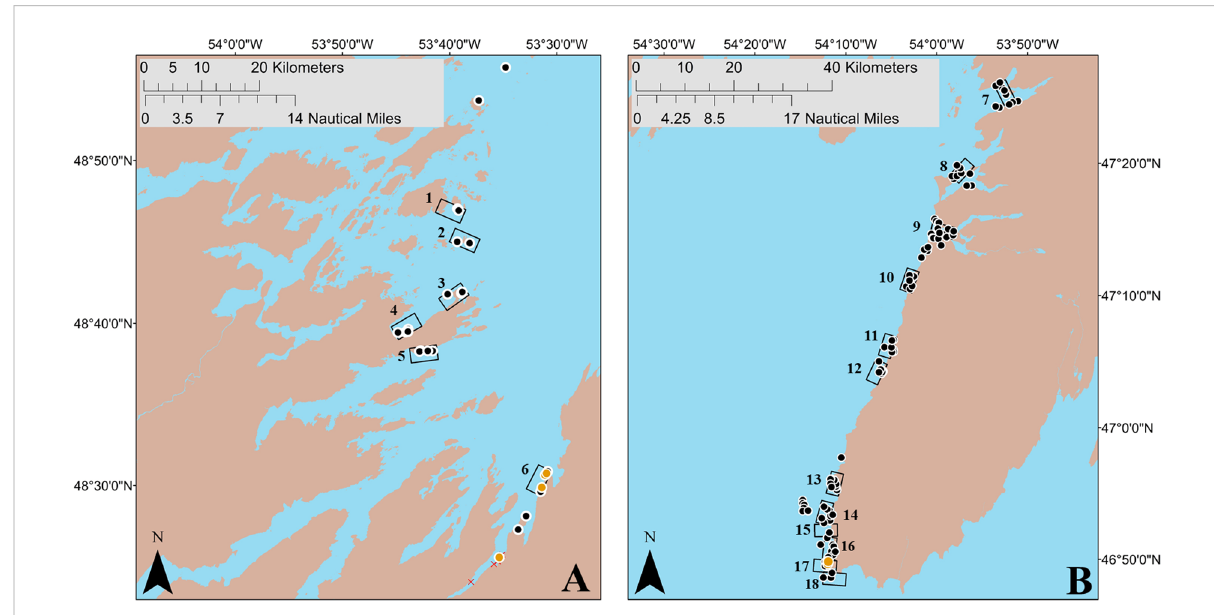
FIGURE 3 Boat-based search areas (18 areas; rectangles) based on putative deep-water spawning areas identi fi ed by interviewees, along with random and adaptive sites (162; black circles), where underwater camera surveys and sediment sampling for capelin spawning (i.e. presence of capelin eggs) were conducted during July – August 2019. Beach sites (21; red X symbol) and deep-water sites where capelin eggs were found (7; orange circles) during July 2019 are also indicated. Panel (A) (left): Bonavista Bay, capelin fi shing area 5. Panel (B) (right): Placentia Bay, capelin fi shing area